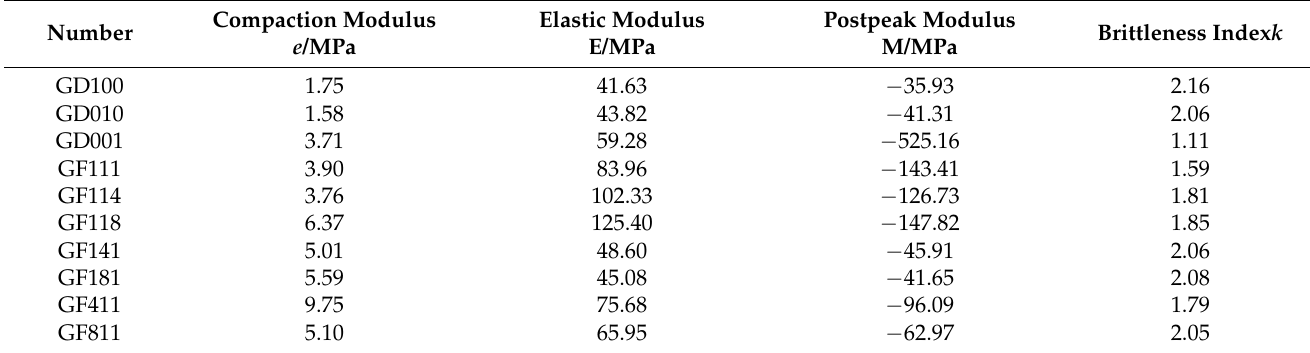
Table 3. Modulus of tectonic coal with different particle